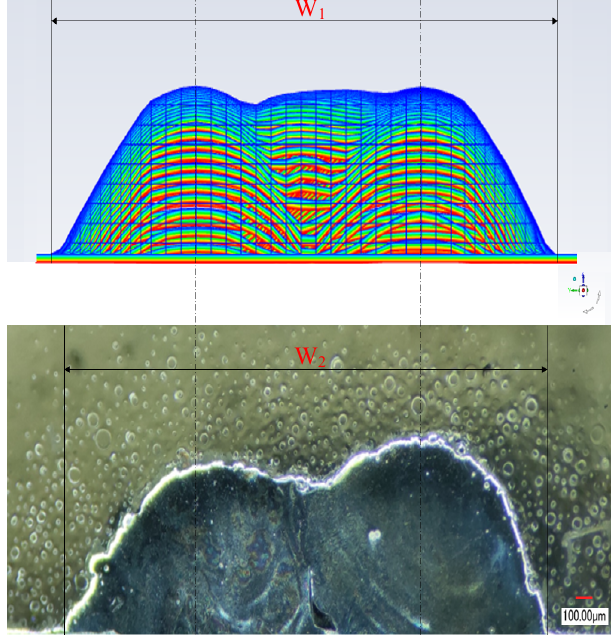
Figure 13. Comparison of simulated and experimental overlapping deposition morphology.